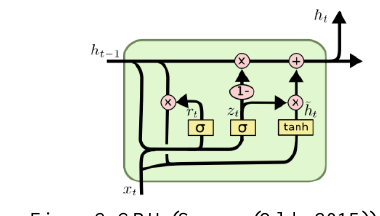
Figure 2. GRU (Source: (Olah,